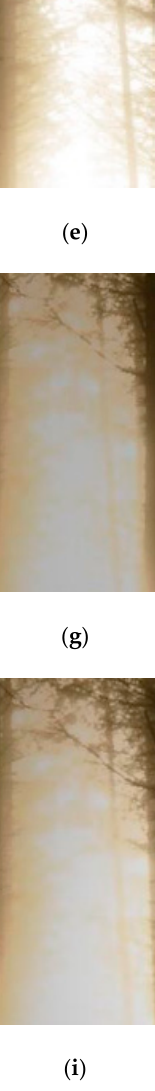
Figure 9. The simulation results of image 4. ( a – d ) are the simulated displayed images processed by the four algorithms, the regions in the red circles in ( a – d ) are enlarged and shown in ( f – i ), ( e ) is the same region of the reference image. ( a ) GFWA, ( b ) LUT, ( c ) FWA, ( d ) ISFLA, ( e ) Reference resources, ( f ) GFWA, ( g ) LUT, ( h ) FWA, ( i )